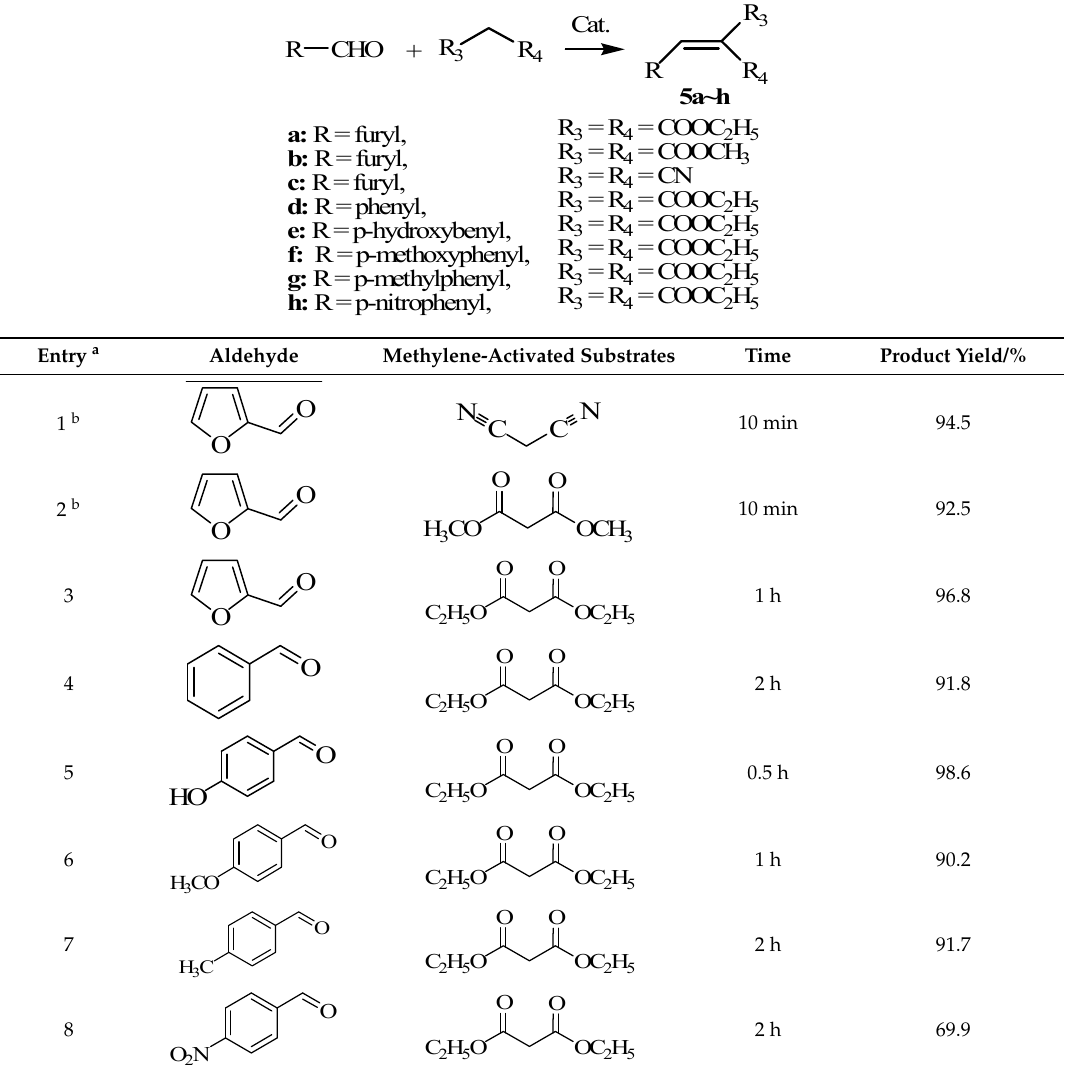
Table 4. Knoevenagel condensation of aromatic/heterocyclic aldehydes with methylene ‐ activated substrates catalyzed by 3 ‐ pyrrolidinamine. Cat. R CHO + R 3 R 4